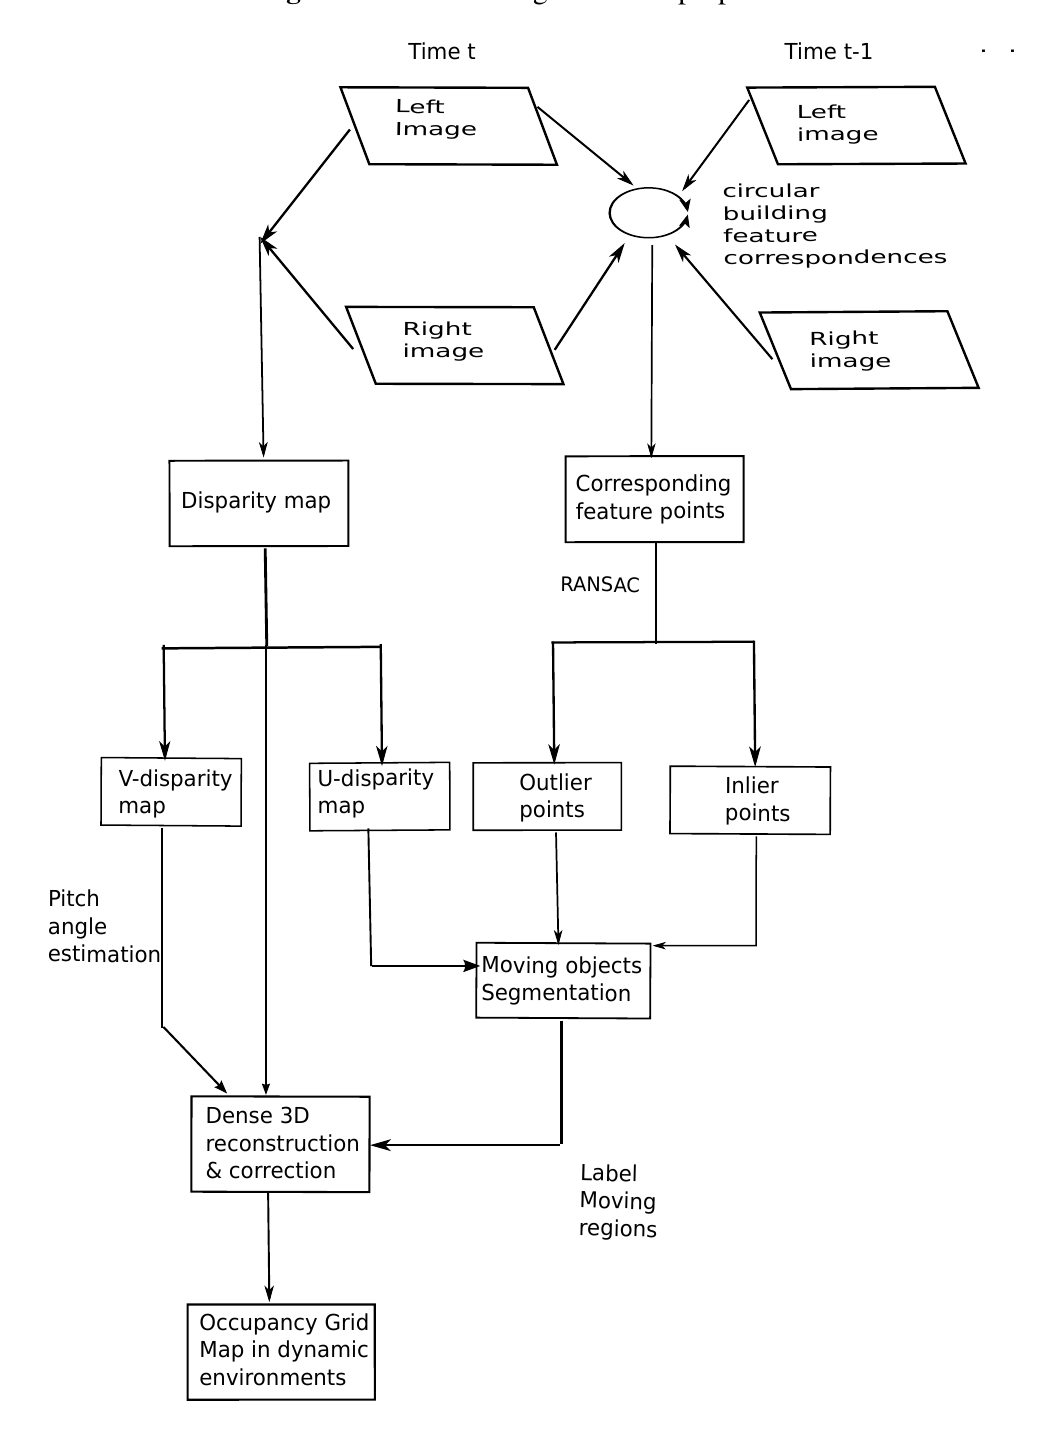
Figure 1. The flow diagram of the proposed